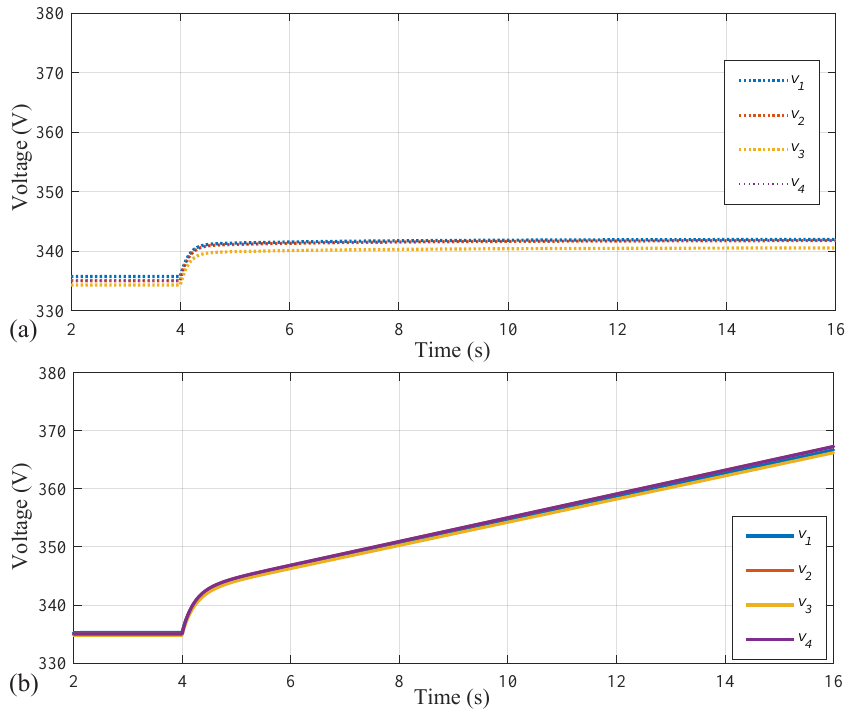
Figure 6. Voltage performance under unbounded actuator attacks: ( a ) proposed resilient method and ( b ) conventional control